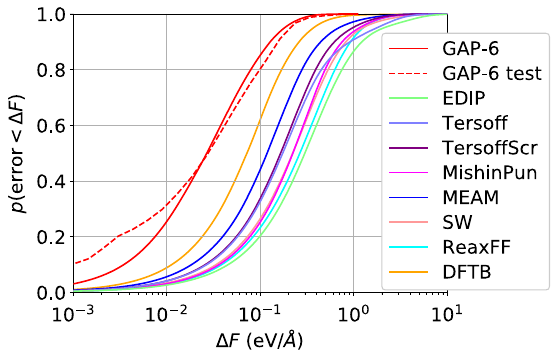
FIG. 3. Cumulative probability distribution of force component errors (relative to reference DFT calculations) for all potentials evaluated on the GAP model-fitting database (solid lines) and for the GAP model only on a separate testing database (dashed